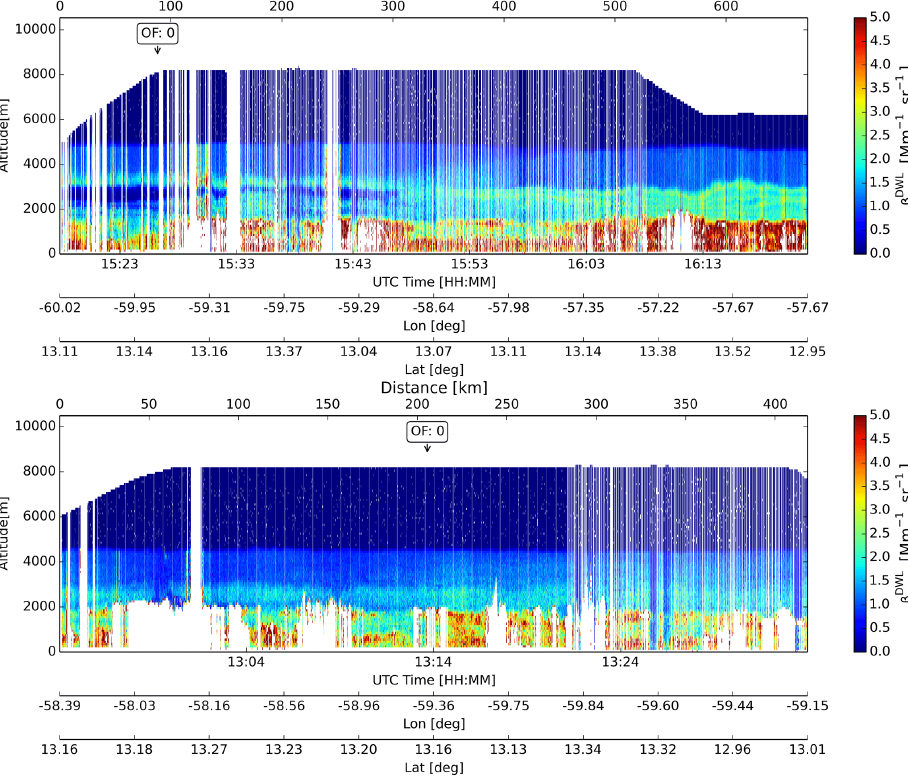
Figure 16. Overview of the retrieved backscatter coefficient for the flights on the 10 July (upper panel) and 11 July (lower panel). The label “OF” indicates the approximated time of the overflight over POLIS lidar. The white color indicates regions were no atmospheric signal is available (e.g., below clouds, low laser